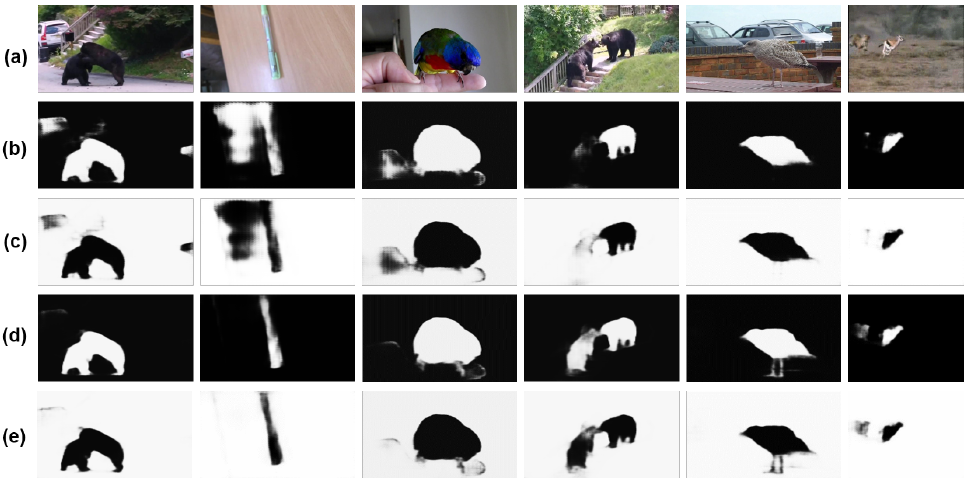
Figure 5. Foreground and background maps initialized by CSNet as well as their interaction and union maps, ( a ) video frames, ( b ) foreground maps and ( c ) background maps generated by CSNet without the complementary loss. ( d ) Foreground maps and ( e ) background maps generated by CSNet with the complementary